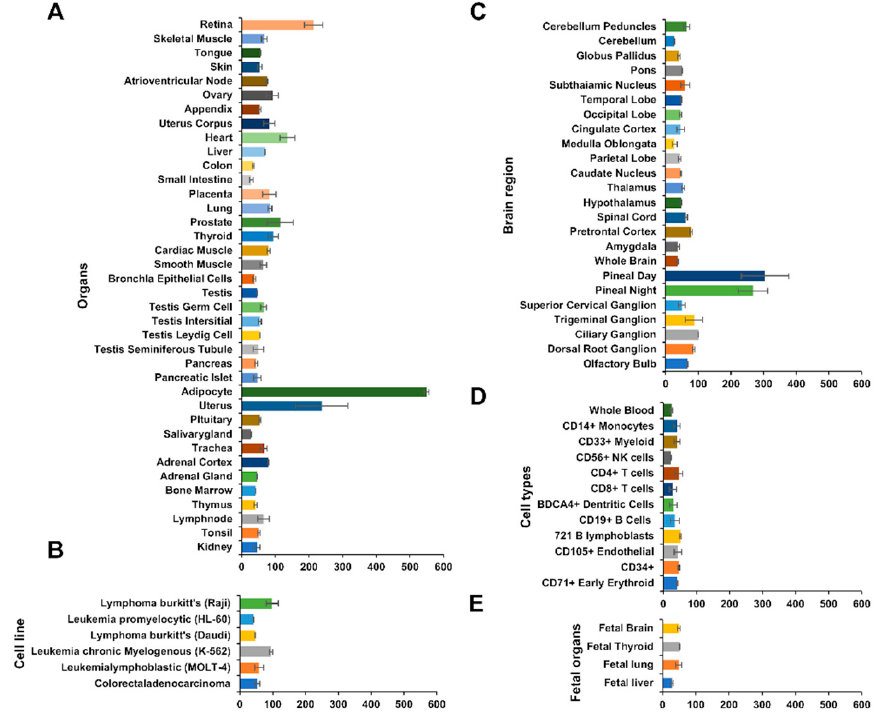
Figure 2. The expression of MFG-E8 in 38 normal tissues, 6 cell lines, 24 brain regions, 12 cell types and 4 fetal organs. Data were derived from BioGPS (Dataset: GeneAtlas U133A, gcrma; http://biogps.org/#goto=genereport&id=4240). The human MFG-E8 mRNA expression in 38 normal tissues ( A ); 6 cell lines ( B ); 24 brain regions ( C ); 12 cell types, ( D ) and 4 fetal organs ( E ). The median of the X-axis is 51.4.